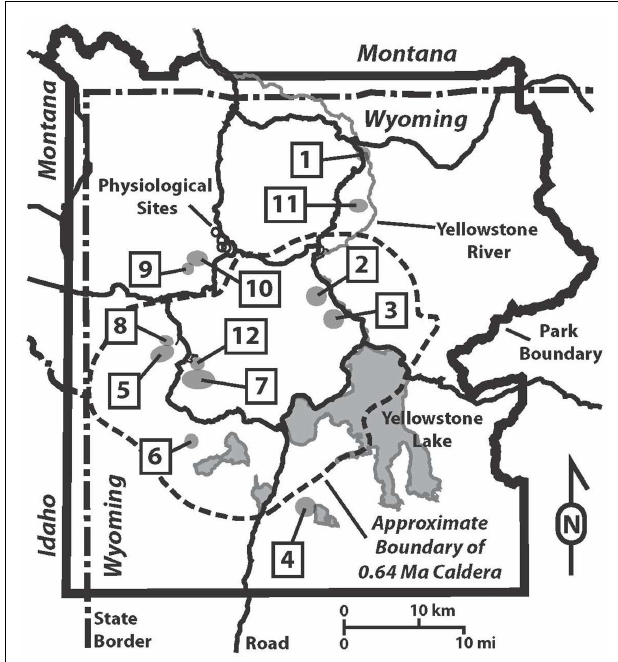
FIGURE 1 | Map ofYellowstone National Park showing hydrothermal areas sampled and locations of physiological sites. Hydrothermal areas are numbered alphabetically: 1, Calcite Springs; 2, Crater Hills; 3, Obsidian Pool Area; 4, Heart Lake; 5, Imperial Geyser Basin; 6, Lone Star; 7, Rabbit Creek; 8, Sentinel Meadows; 9, South of Sylvan Springs; 10, Sylvan Springs; 11,Washburn; 12,White Creek. Physiological samples, represented with open circles, in order from Northwest to Southeast are Bijah Spring, Nymph Creek, Dragon Spring, and Perpetual Spouter.